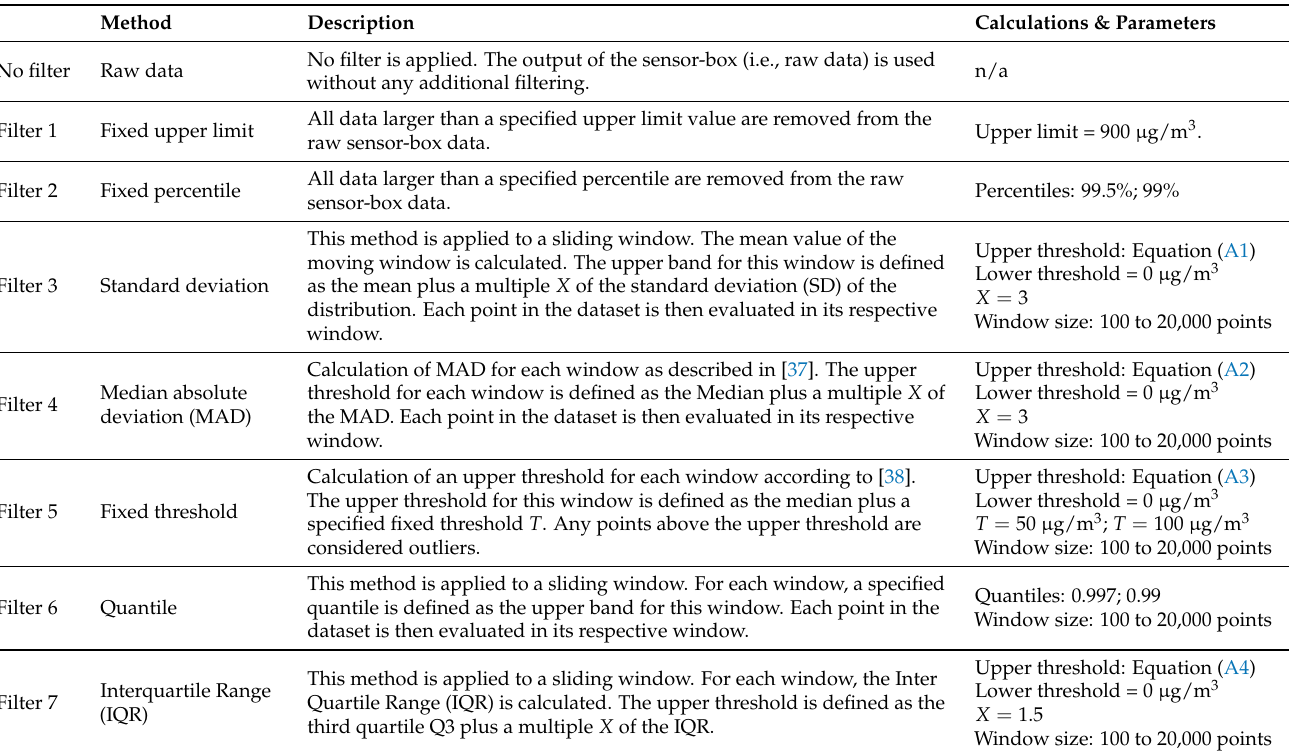
Table A1. Overview of tested filtering methods for outlier detection applied to raw PM 10